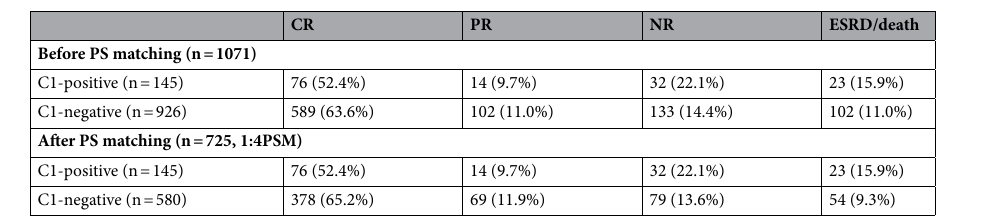
Table 3. Clinical outcome of IgAN patients. Values for categorical variables are given as number (percentage). CR complete remission, PR partial remission, NR no response, ESRD end stage renal